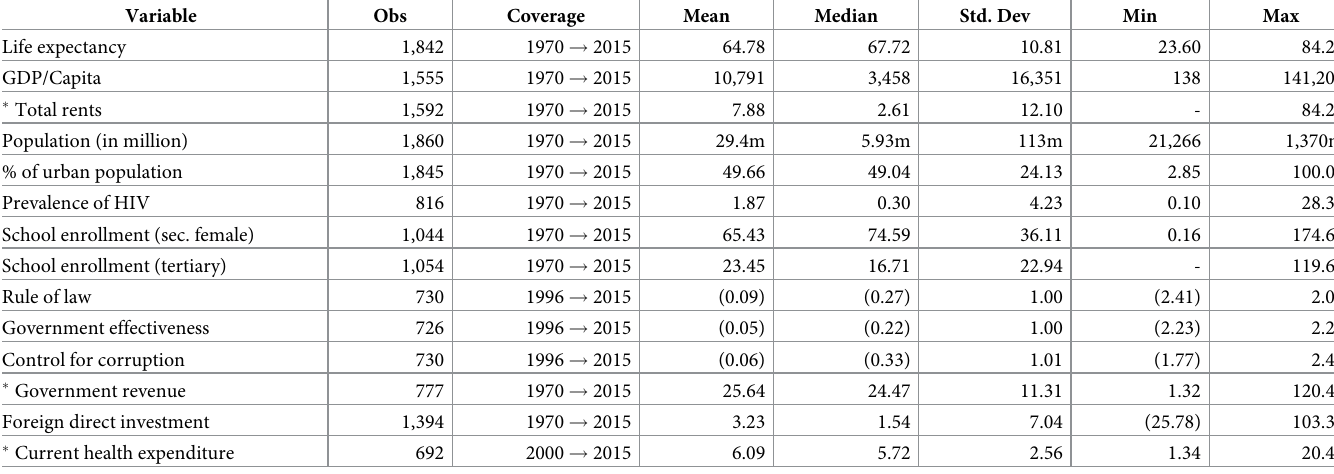
Table 1. Descriptive statistics of the underlying indicators.